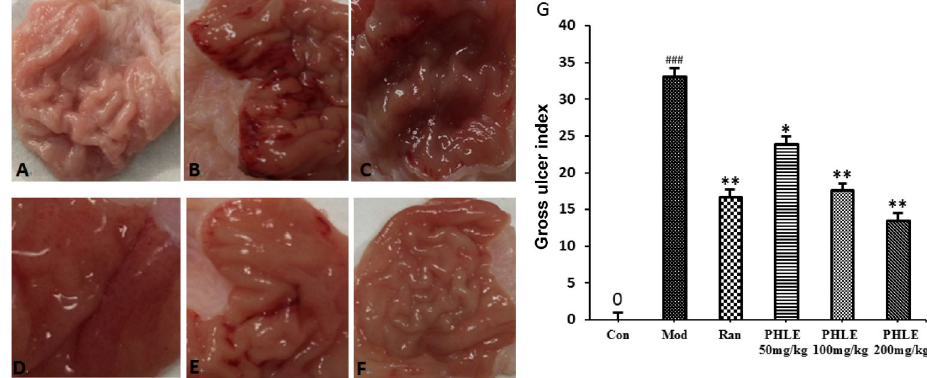
Figure 3. Gross fi ndings of ethanol-induced gastric damage in the rat gastric mucosa. The rats were pretreated with different doses of P. hydropiper extract (PHLE) or ranitidine (Ran). After 1 h, anhydrous ethanol (10 mL/kg) was administered orally. One hour after EtOH administration, the rats were euthanized to evaluate the gross morphology of the gastric mucosa. A : normal control group; B : model group; C : ranitidine group; D : PHLE 50 mg/kg; E : PHLE 100 mg/kg; F : PHLE 200 mg/kg; G : Gross ulcer index. Data are reported as means ± SD. ### P o 0.001 compared to the normal control (Con) group; *P o 0.05 and **P o 0.01 compared to the model (Mod) group (ANOVA and LSD post hoc test).